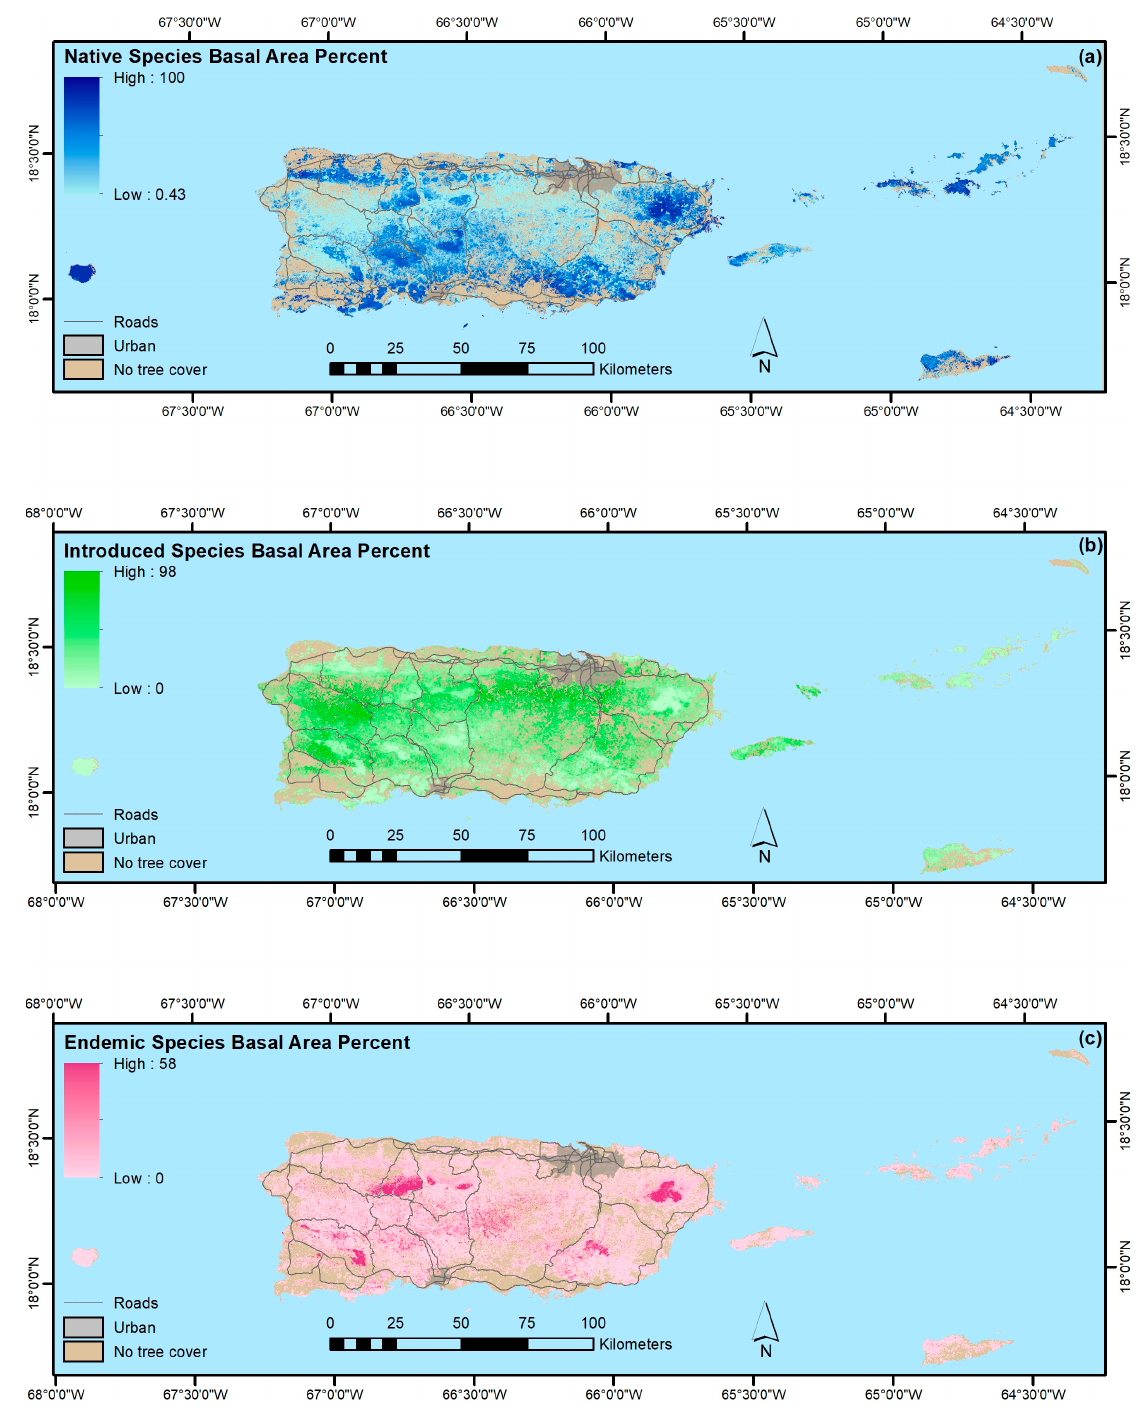
Figure 8. Relative basal areas of ( a ) native species, ( b ) introduced species, and ( c ) endemic species as mapped with Cubist regression tree models.